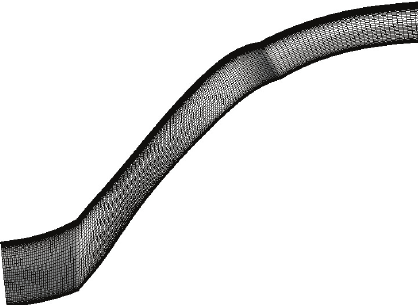
Figure15:Meridionalviewofthecomputationalmeshforthe mixed flow rotor